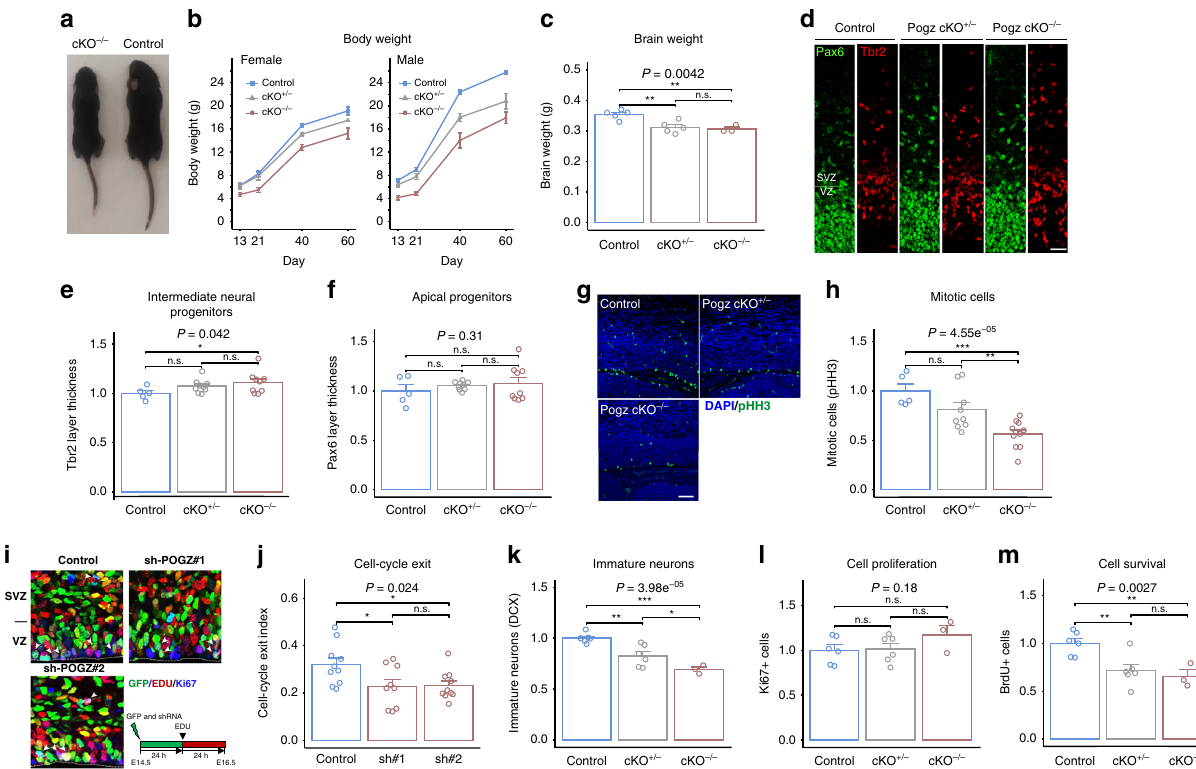
Fig. 2 Pogz -de fi cient mice show growth delay, changes in brain size, and altered neurogenesis. a Comparison of the body size of Pogz cKO − / − and control mice littermates (P11). b Body weight in four time points (P13, P21, P40, P60). Repeated measures ANOVA; n = 16 control (blue), 7 cKO + / − (gray), 7 cKO − / − (red), P = 1.1 × 10 − 15 . c Brain weight at P11. n = 5 control, 5 cKO + / − , and 3 cKO − / − . d Coronal sections of embryonic cerebral cortex (E15.5) stained with anti-Pax6 and Tbr2 antibodies. Scale bar = 50 μ m. VZ ventricular zone, SVZ subventricular zone. e , f Quanti fi cation of the thickness of the Tbr2 + and Pax6 + layers. Values are proportion relative to control mice. n = 5 control, 9 cKO + / − , 9 cKO − / − in four independent experiments. g , h Coronal sections of cerebral cortices (E15.5) stained with DAPI and antibody against phosphorylated histone 3 (pHH3). Scale bar = 100 μ m. h Quanti fi cation of the number of the pHH3 + cells. Values are proportion relative to control mice. n = 5 control, 9 cKO + / − , 11 cKO − / − in two independent experiments. i , j Effects of Pogz-silencing on cell-cycle exit. i Differentiated neurons are EdU/GFP-double-positive while EdU/Ki67/GFP-triple-positive cells maintain progenitor potency. Arrowheads indicate triple-positive cells. Scale bar = 10 µ m. At the bottom right is the scheme of the cell-cycle exit assay. j Quanti fi cation of EdU/ Ki67/GFP-triple-positive cells among GFP/EdU double-positive ones (Cell exit index). Two sections were used per brain (more than 1600 cells were analyzed in each condition). n = 10 control, 9 sh-Pogz#1 (sh#1), 10 sh-Pogz#2 (sh#2) from two in utero independent experiments. k − m Reduced adult neurogenesis associated with Pogz de fi ciency. Quanti fi cation of either k DCX-positive cells, l Ki67-positive cells, m BrdU-positive cells in the dentate gyrus, 21 days post injection. Numbers are proportion relative to control mice. n = 6 control, 6 cKO + / − , 3 cKO − / − . The P values at the top of the plots are for the association between the quantitative measurements and the number of intact Pogz alleles calculated with a linear regression model. Pairwise comparisons between genotypes was calculated by two-tailed t test and the signi fi cance is represented by: * P < 0.05; ** P < 0.01; *** P < 0.001; n.s. not signi fi cant. Quantitative data are mean ±